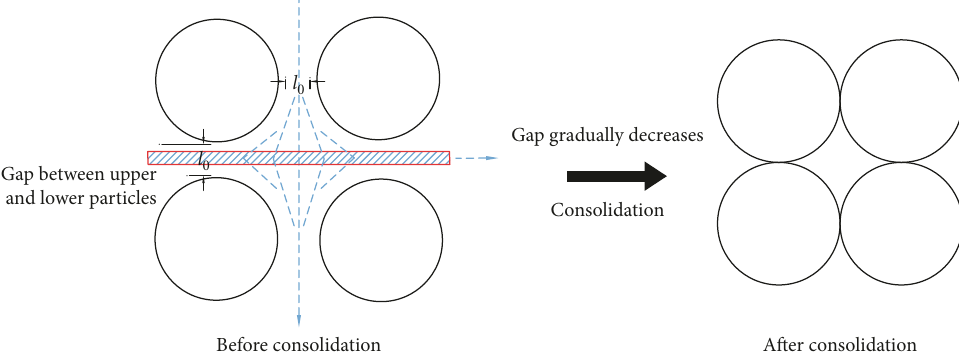
Figure 10: The change of gap during the process of